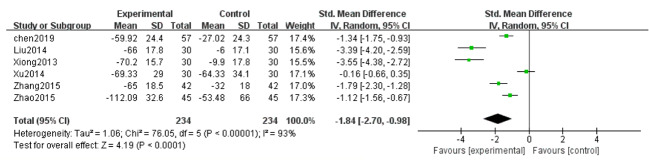
Forest plot for urinary albumin excretionrate (UAER) between the treatment group and control group.